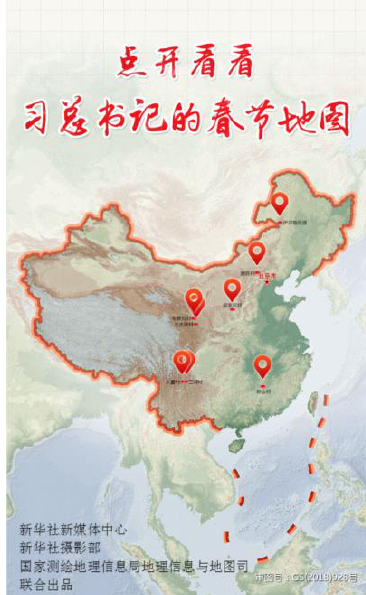
Figure 3. Click to see Xi’s Spring Festival